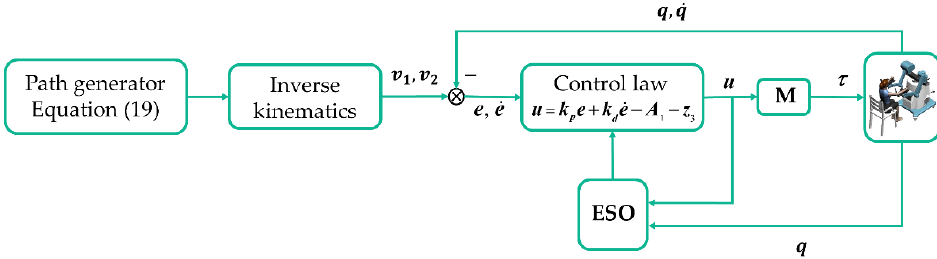
Figure 3. ADRC position control block diagram.